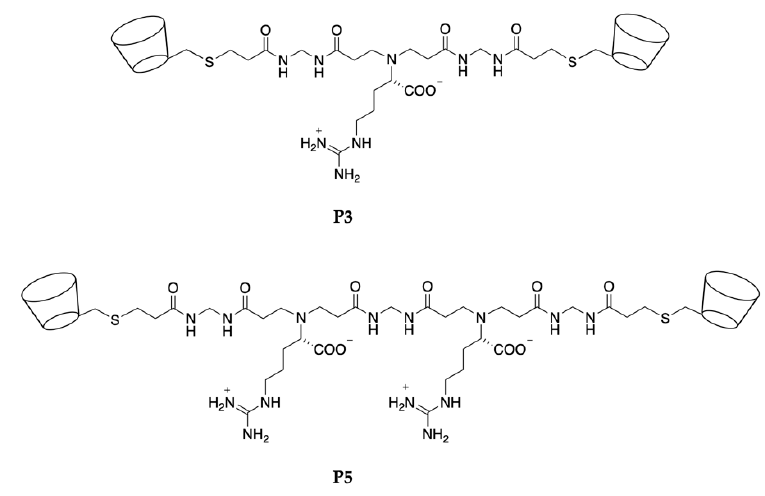
Figure 1. Structures of the P3 and P5 β -cyclodextrin α , ω -end-functionalized PAA oligomers. P3 and P5 are amphoteric and exhibit a pH-dependent charge distribution, as Table 1. pH-dependent ionic species distribution in the repeat units of P3 and P5 a . < 10 and fully dissociated carboxyl groups at pH > 4. The protonation degree of the tert - pH COO − Units (%)